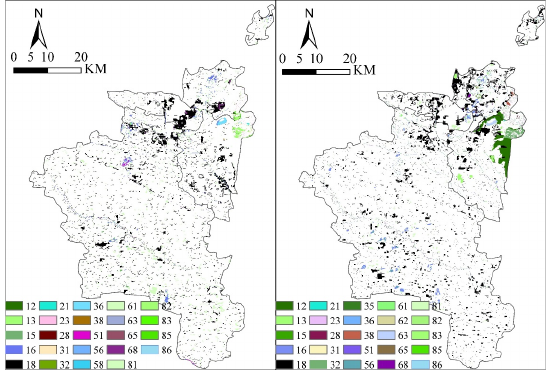
Figure 8. 2000–2020 land use change areas (number “1” represents meadows, number “2” represents shrubs, number “3” represents farmland, number “4” represents artificial land, number “5” represents forests, number “6” represents water, number “13” represents the conversion of shrubs to